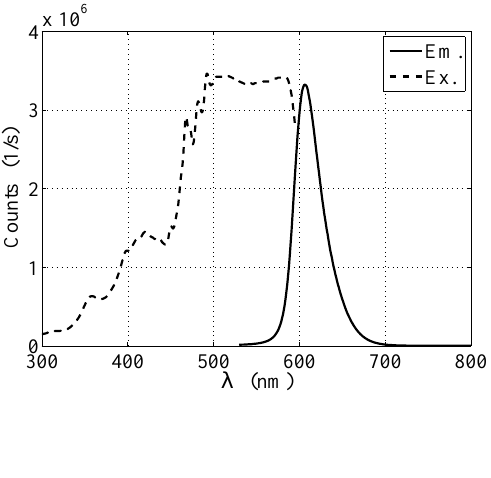
Figure 4. Emission, Em., and excitation, Ex., spectra for the in-house developed orange-fluorescent